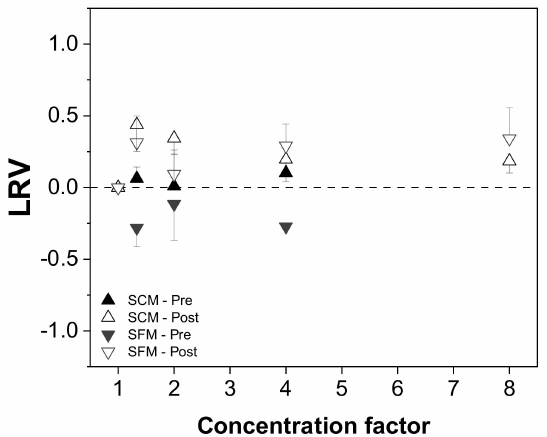
Figure 4. Relationship between the infectious virus titer and process concentration mode (before or after diafiltration) in serum-containing and serum-free media. The change in the total infectious virus titer is expressed as a log reduction value (LRV) [37]. Table 3. Mean retention coefficients ( ± SEM) in the concentration steps before and after diafiltration. CF = concentration factor [37]. Serum-Containing Medium Serum-Free